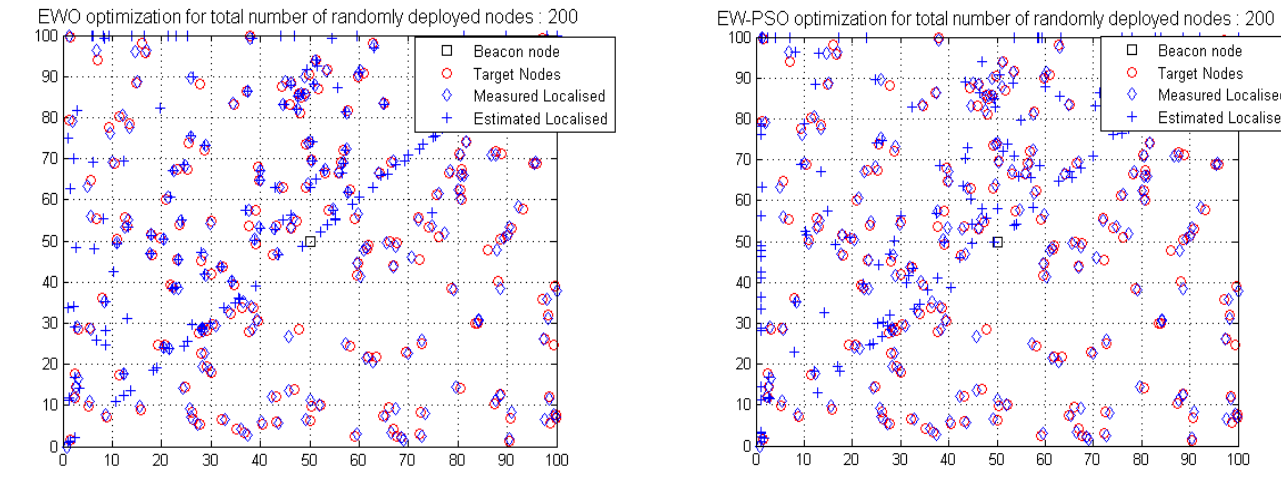
Figure 5. EWO algorithm for randomly deployed mobile sensor nodes located in the target area